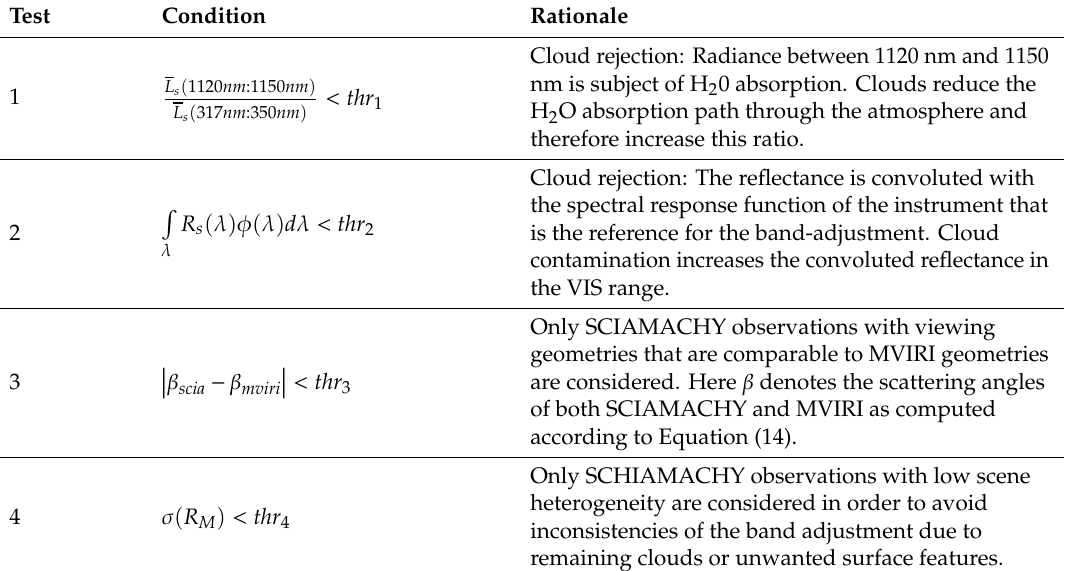
Table 5. Tests for filtering SCIAMACHY spectra. Values for thr1, thr2 and thr3 are given in Table 4.